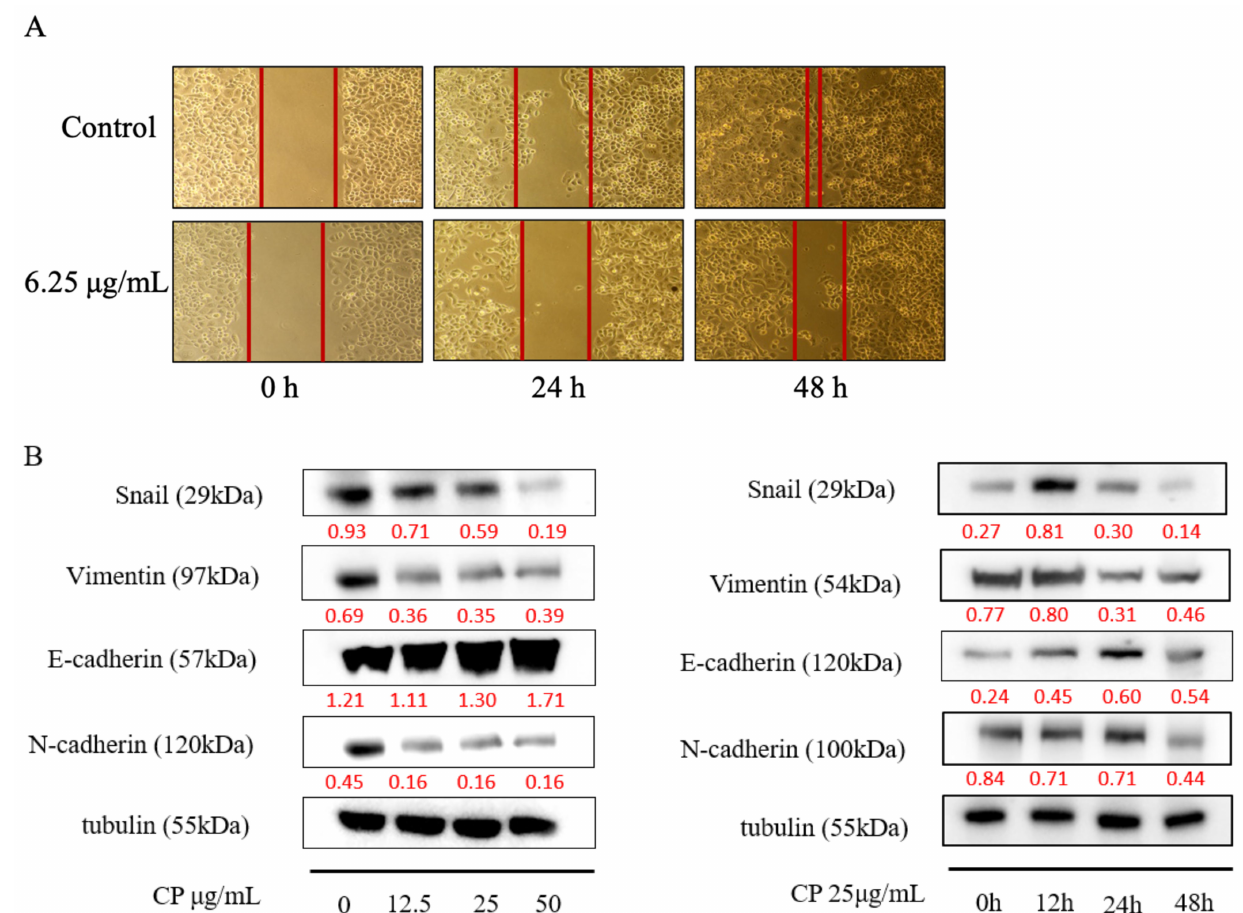
Figure 5. CP inhibited the migration of Panc-1 cells by inhibiting the EMT process. ( A ) CP suppressed migration of Panc-1 cells at a non-fatal concentration of 6.25 µ g/mL. ( B ) The expression of EMT-related proteins was analyzed by Western blot with different concentrations and treatment